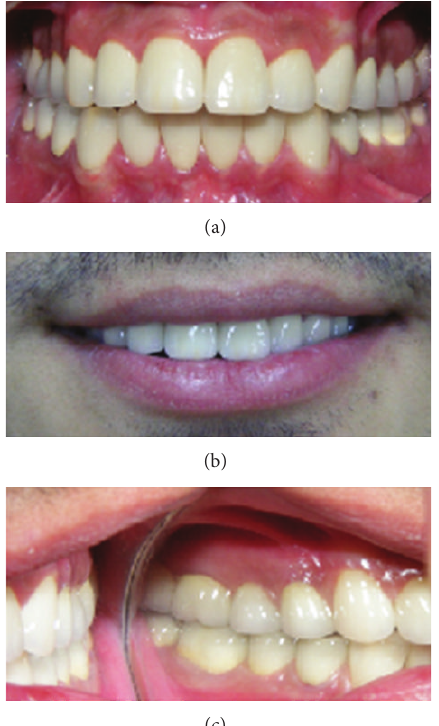
Figure 6: Intraoral appearance of prosthetic